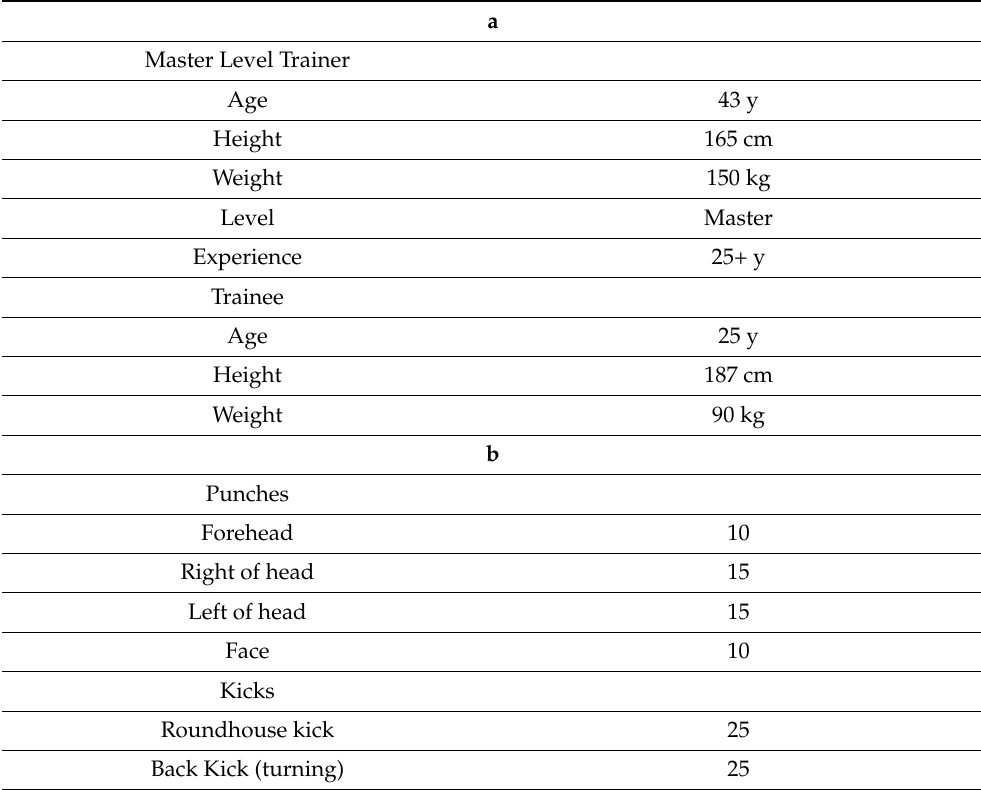
Table 2. a. Trainer details. b. Data set division.